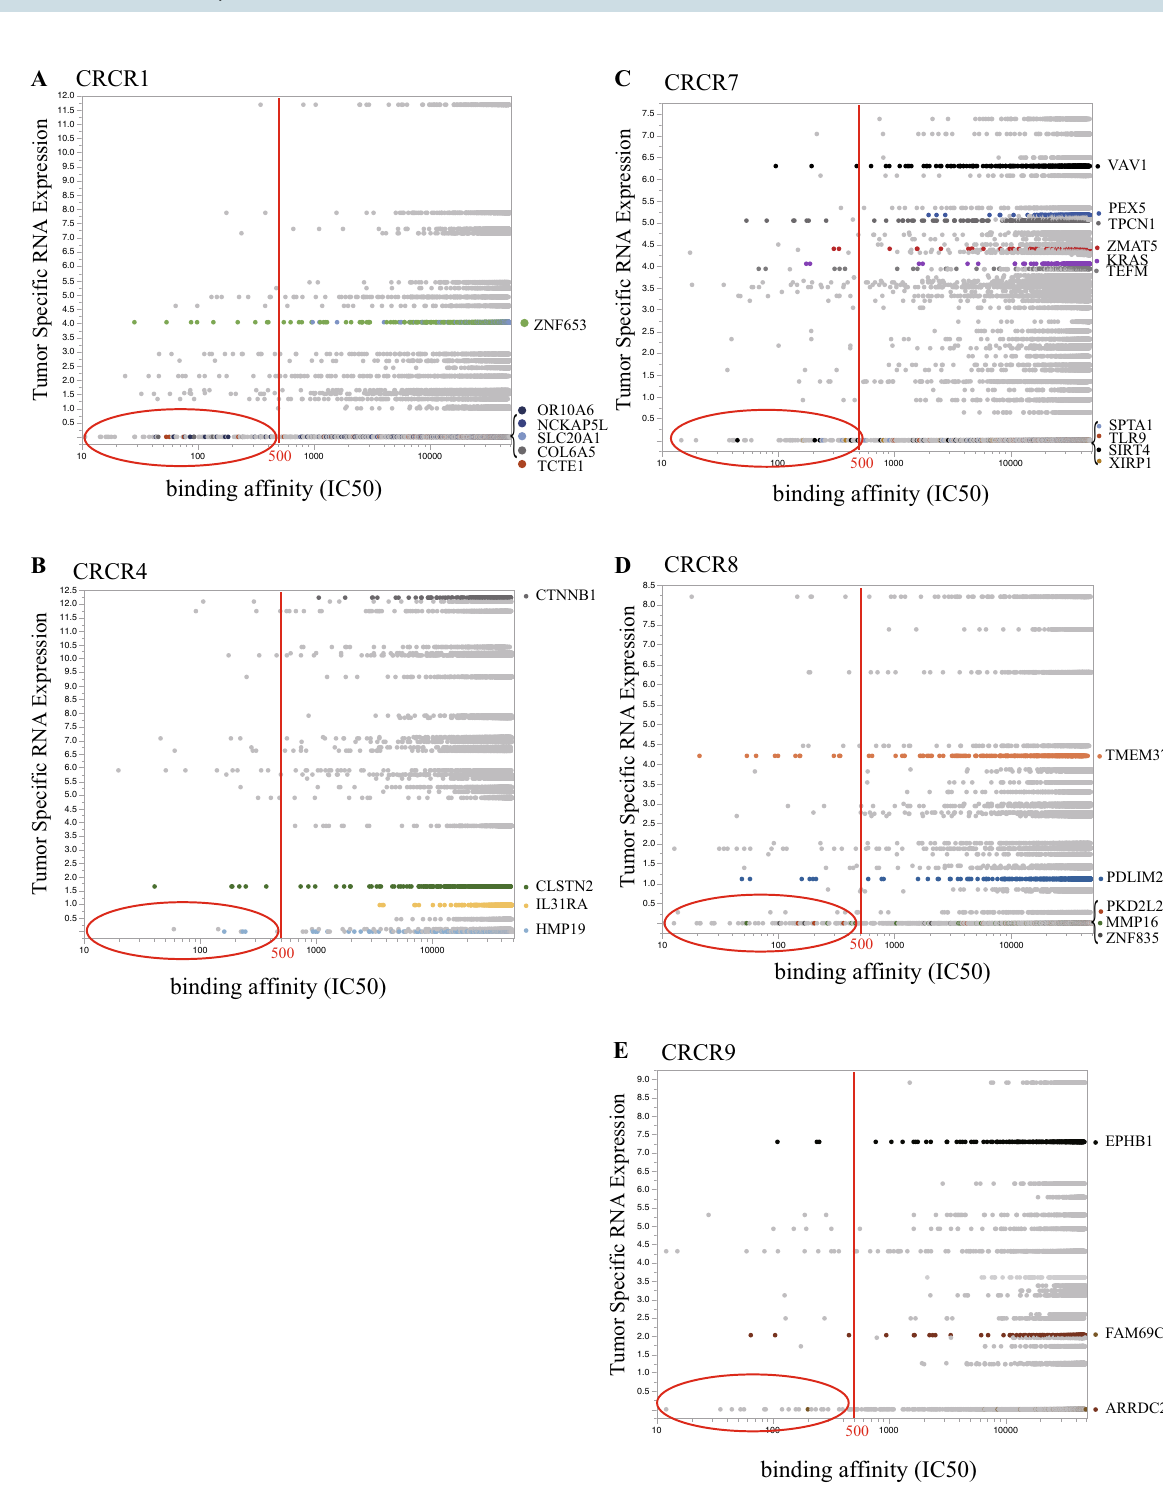
Figure 3. Immunogenicity of estimated NAG peptide in each mutated ctDNA gene. In terms of neoantigen analysis for MHC restriction of ctDNA, the binding affinity of peptide fragments to HLA-A, -B, -C was estimated using SNVs with WES data of primary sites (neBindingtMHCpan) (X-axis) . The binding affinity of peptides was calculated as the IC50. The estimated NAG peptide derived from an SNV within 500 nM (red line) of IC50 indicated weak binding affinity to HLA. In addition, tumor-specific RNA expression was extracted from the tumor RNA BAM file and evaluated (Y-axis) . Neoantigens with a high binding affinity but no expression were spotted in a red elliptic